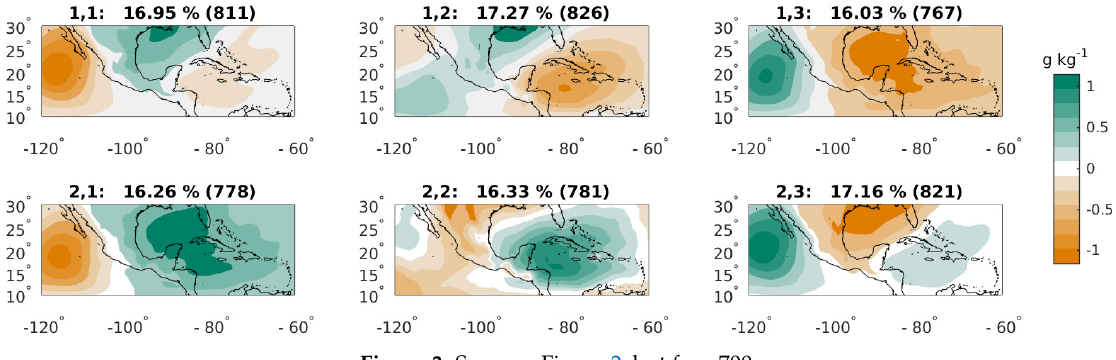
Figure 3. Same as Figure 2, but for q700.